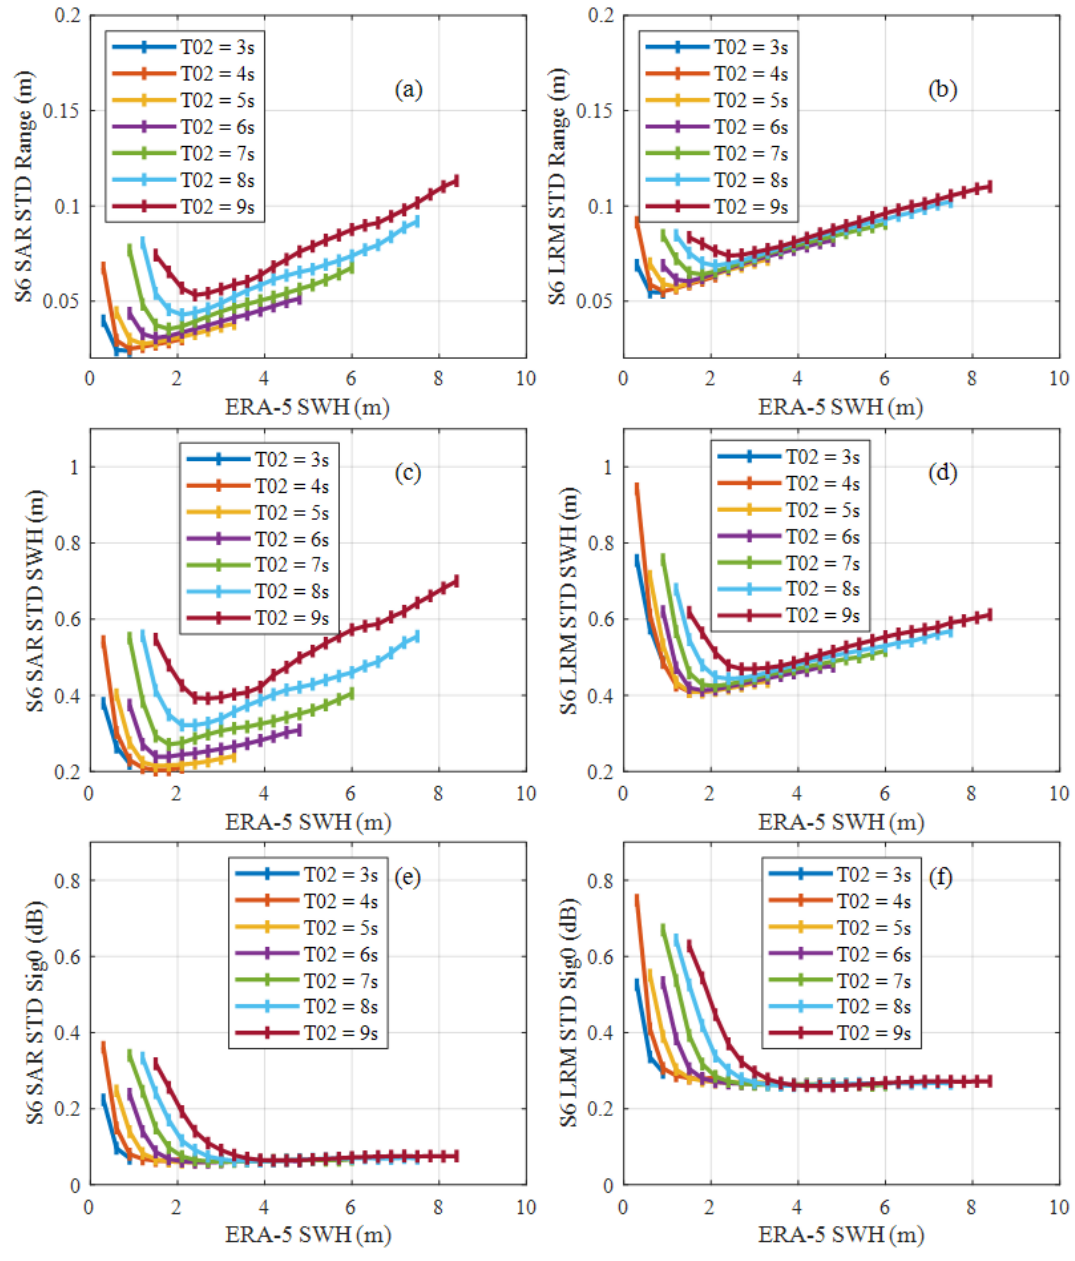
Figure 18. STD s of 20 Hz Sentinel-6 SARM ( left ) and LRM ( right ) range, SWH and sigma0 against ERA5 SWH estimates for seven different T02